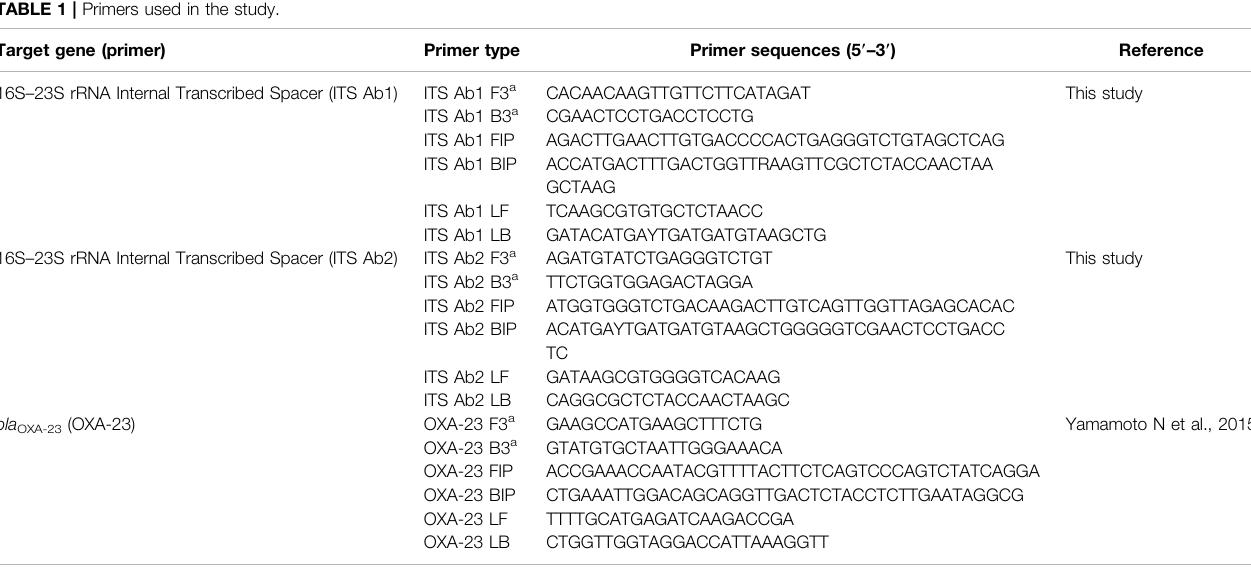
TABLE 1 | Primers used in the